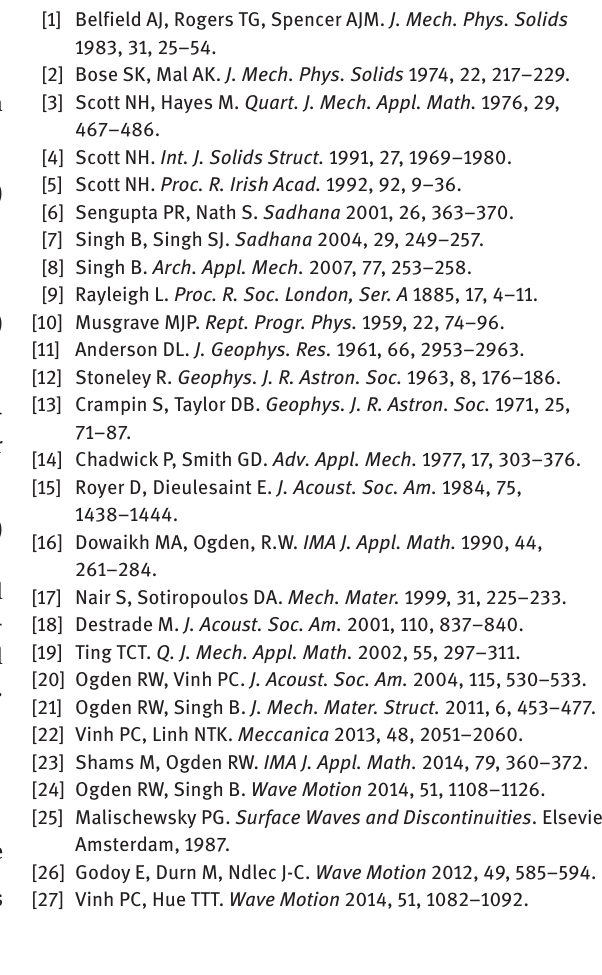
* = 0, Z * = 0 (dotted is plotted against ξ in Figure 1 for Z 1 2 * = -0.02, Z * = -0.03 (solid curve),and for curve), for Z 1 2 * = 0.02, Z * = 0.03 (solid curve with centre symbols). The Z 1 2 non-dimensional wave speed increase sharply with the increase in value of ξ . However, this sharpness decreases slowly with the increase in ξ . The comparison of these curves in Figure 1 shows the effect of impedance on non- dimensional wave speed. The non-dimensional wave * and Z * in speed is also computed and plotted against Z 1 2 Figures 2 and 3, respectively for ξ = 5. From Figures 2 and 3, * and Z * on non-dimen- effect of impedance parameters Z 1 2 sional wave speed is observed